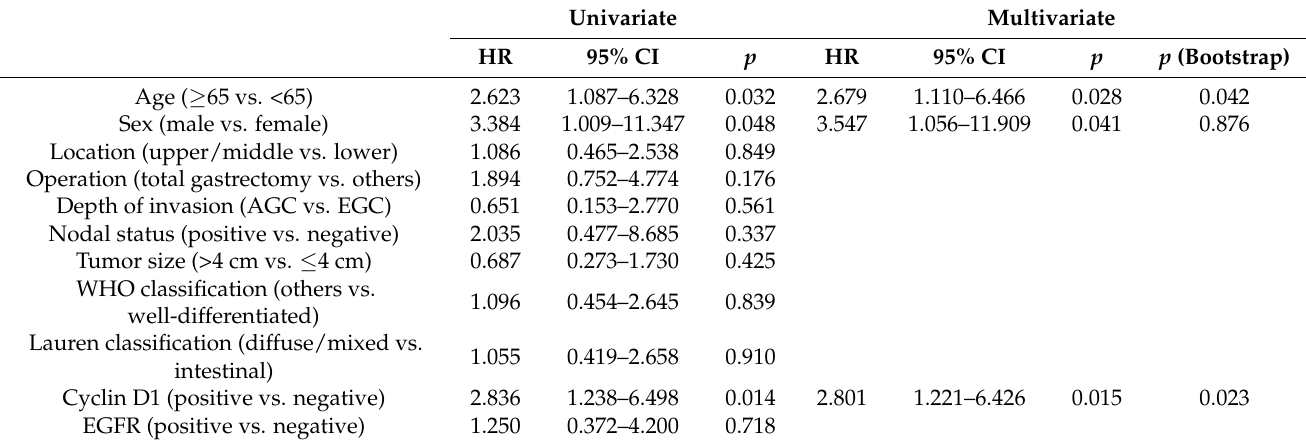
Figure 4. Forest plot for subgroup analyses of overall survival by cyclin D1 positivity. Table 2. Cox regression for overall survival in stage I gastric cancer.